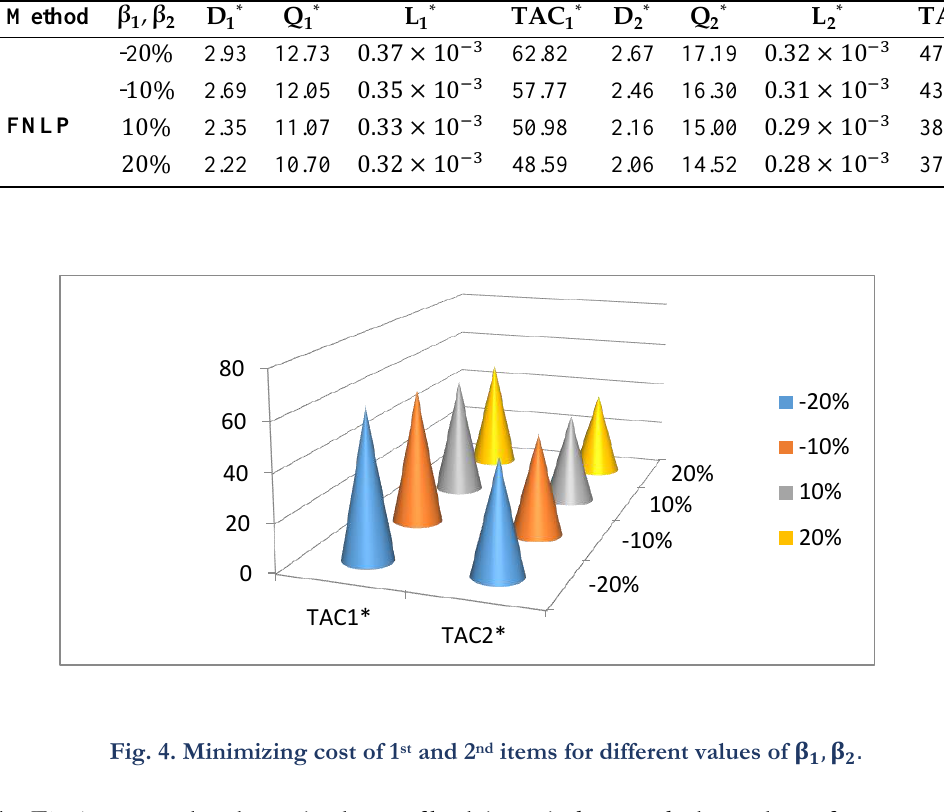
Table 5. Optimal solution of MOIM for different values of 𝛃